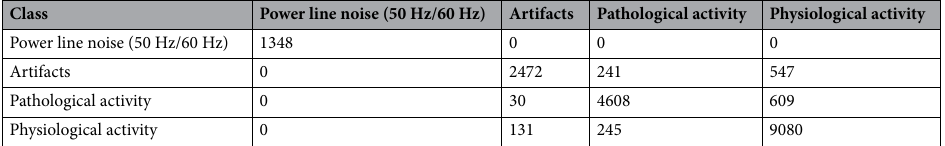
Table 3. The confusion matrix for the model shown in the uniform manifold approximation and projection (UMAP) in Fig. 5.